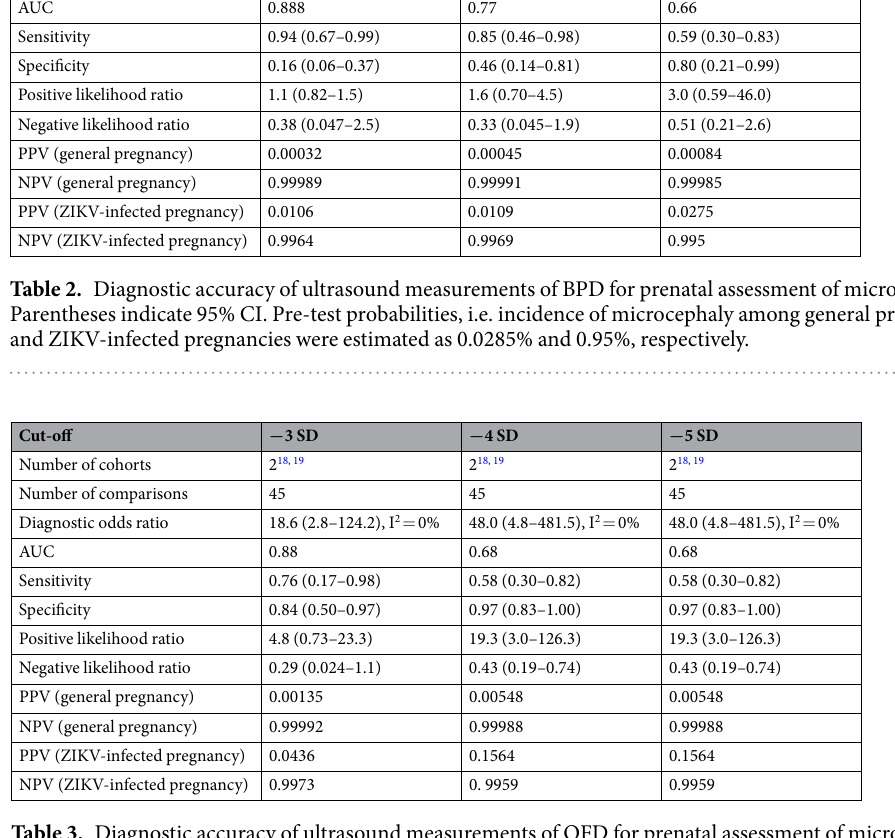
Table 3. Diagnostic accuracy of ultrasound measurements of OFD for prenatal assessment of microcephaly. Parentheses indicate 95% CI. Pre-test probabilities, i.e. incidence of microcephaly among general pregnancies and ZIKV-infected pregnancies were estimated as 0.0285% and 0.95%, respectively.